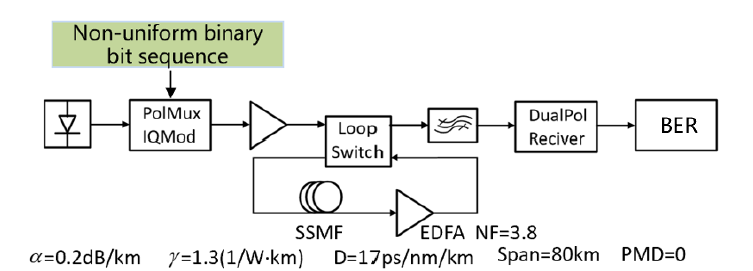
Figure 7. Simulation block diagram and parameters of standard single-mode optical fiber